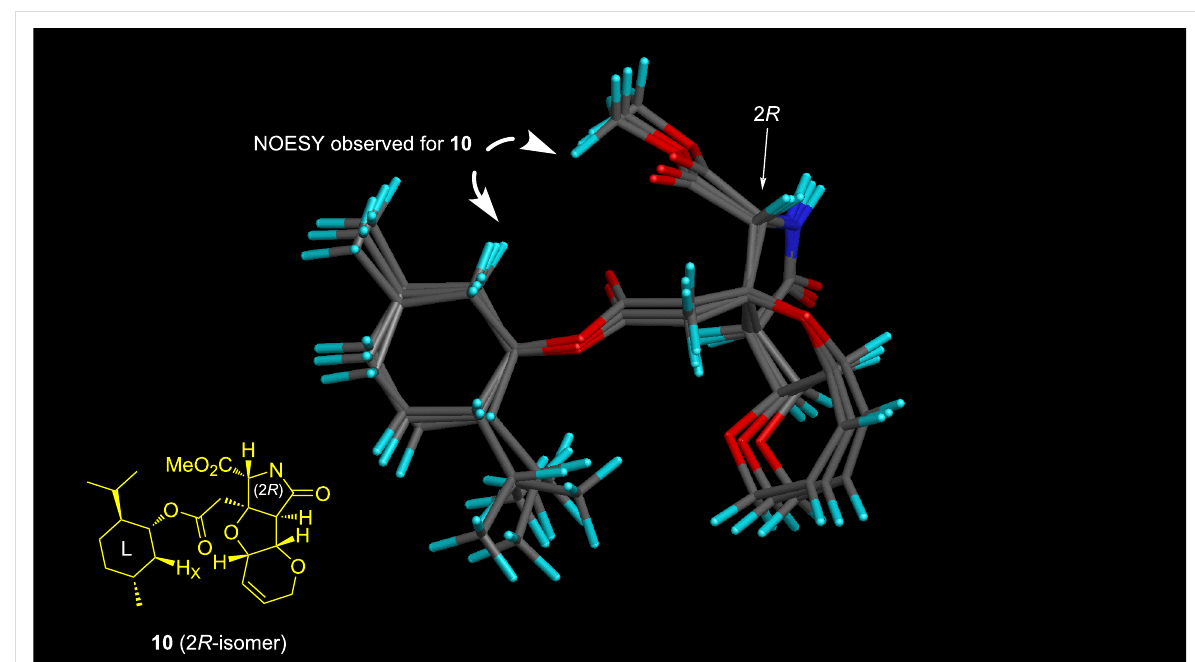
Figure 3: Superimposed structures of the top 3 stable conformers (76.5% total population) generated by CONFLEX (MMFF94S) for the (2 R )-isomer, which is consistent with the NOESY crosspeak observed for 10 (400 MHz, CDCl 3 ). See Supporting Information File 5 for the stereo diagram.